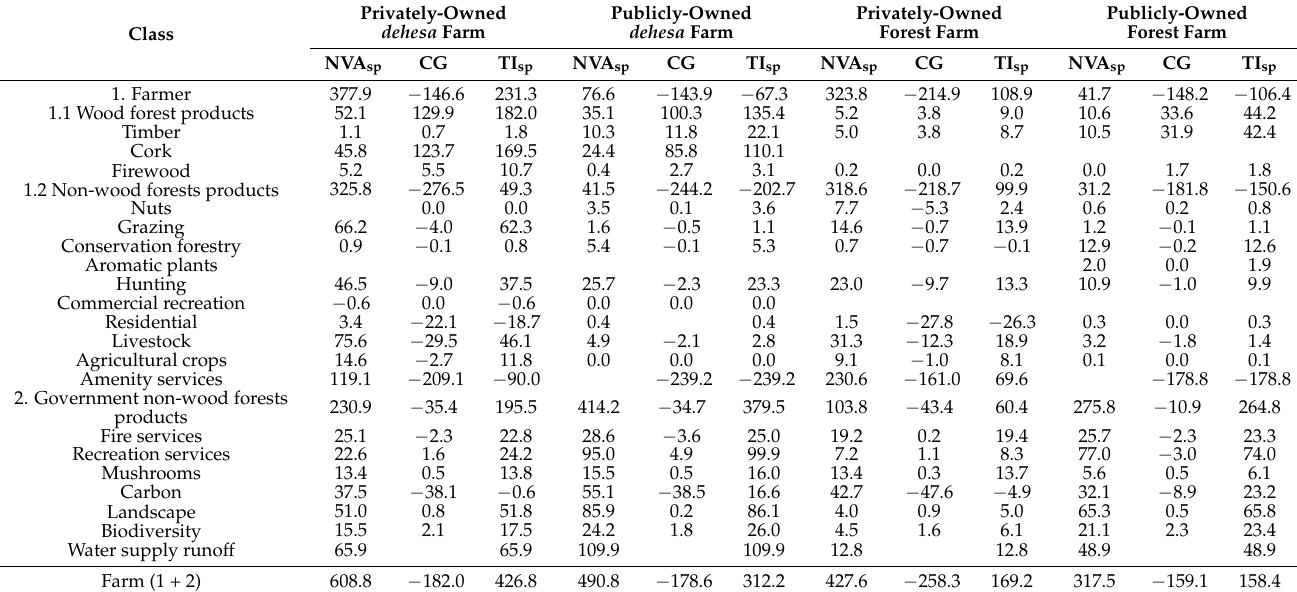
Table 7. Contribution of capital gain to total income of the case-study large dehesa and forest farms in Andalusia under the AAS (2010: €